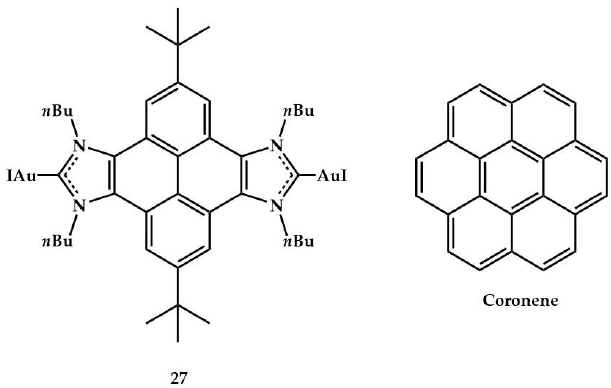
Figure 12. Digold(I) complex 27 and coronene. Figure 12 . Digold(I) complex 27 and coronene.